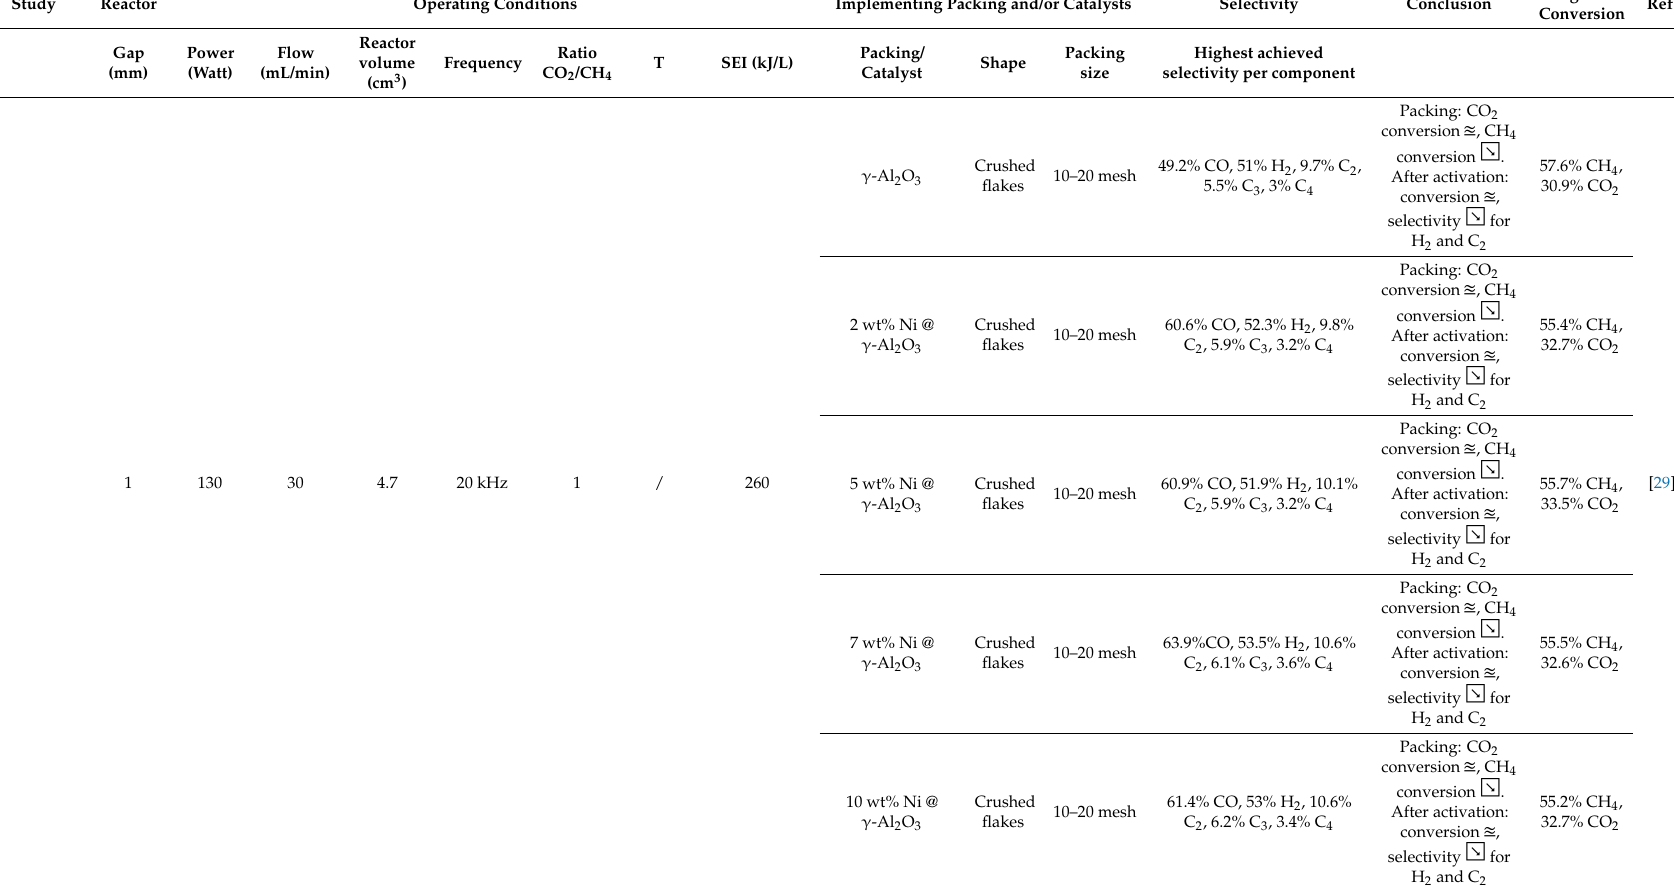
Table 2. Cont. Table 1. Summary of a selection of literature for CO 2 splitting in a non-packed and a packed DBD reactor.